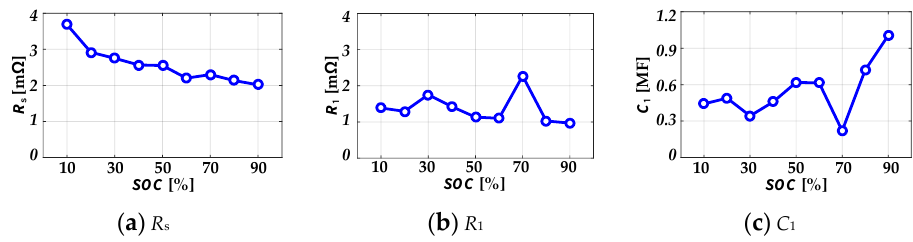
Figure 3. Parameter identification results of conventional model in Figure 2a.